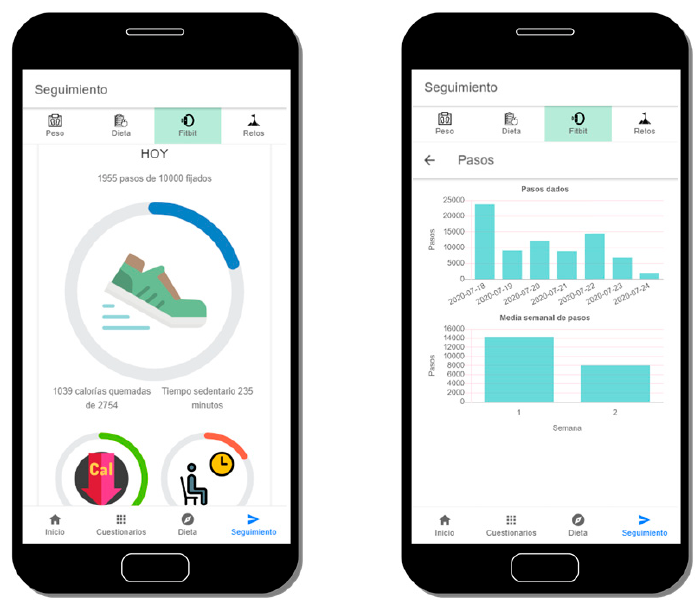
Figure 7. View of the current Fitbit’s data (left) and detailed view of the daily steps aggregated data (right).